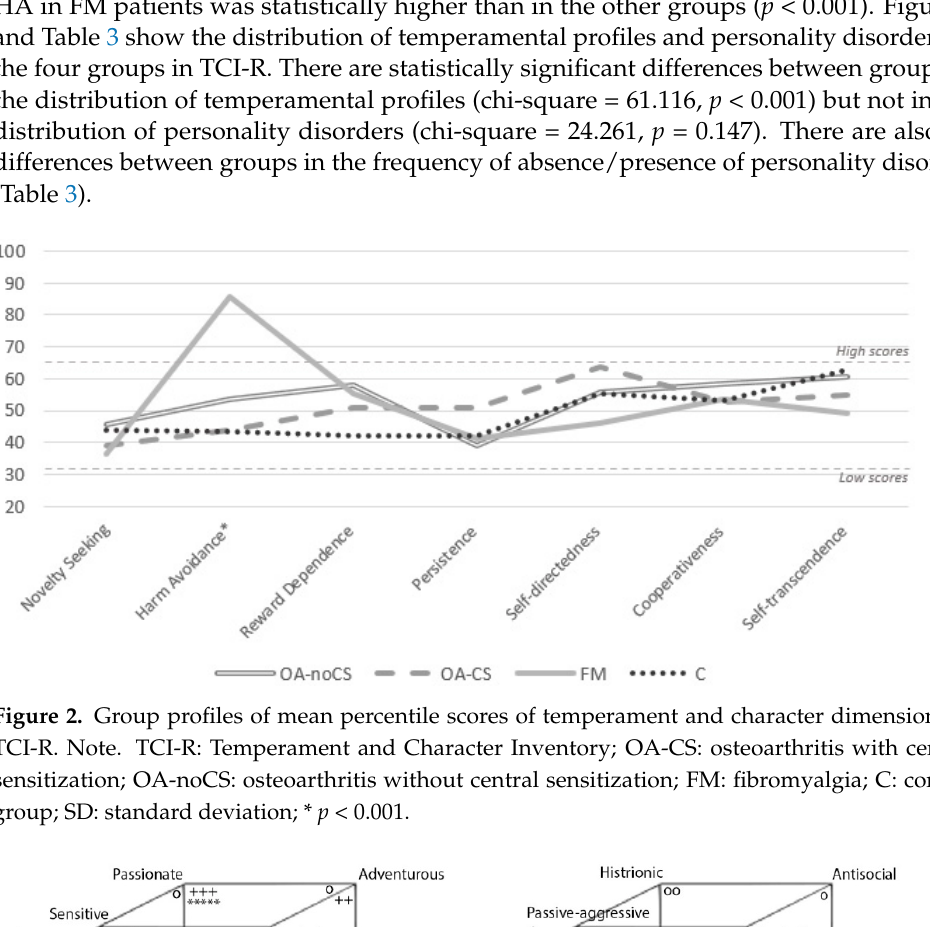
Table 3. Distribution of TCI-R temperamental profiles and TCI-R personality disorders by group. Group